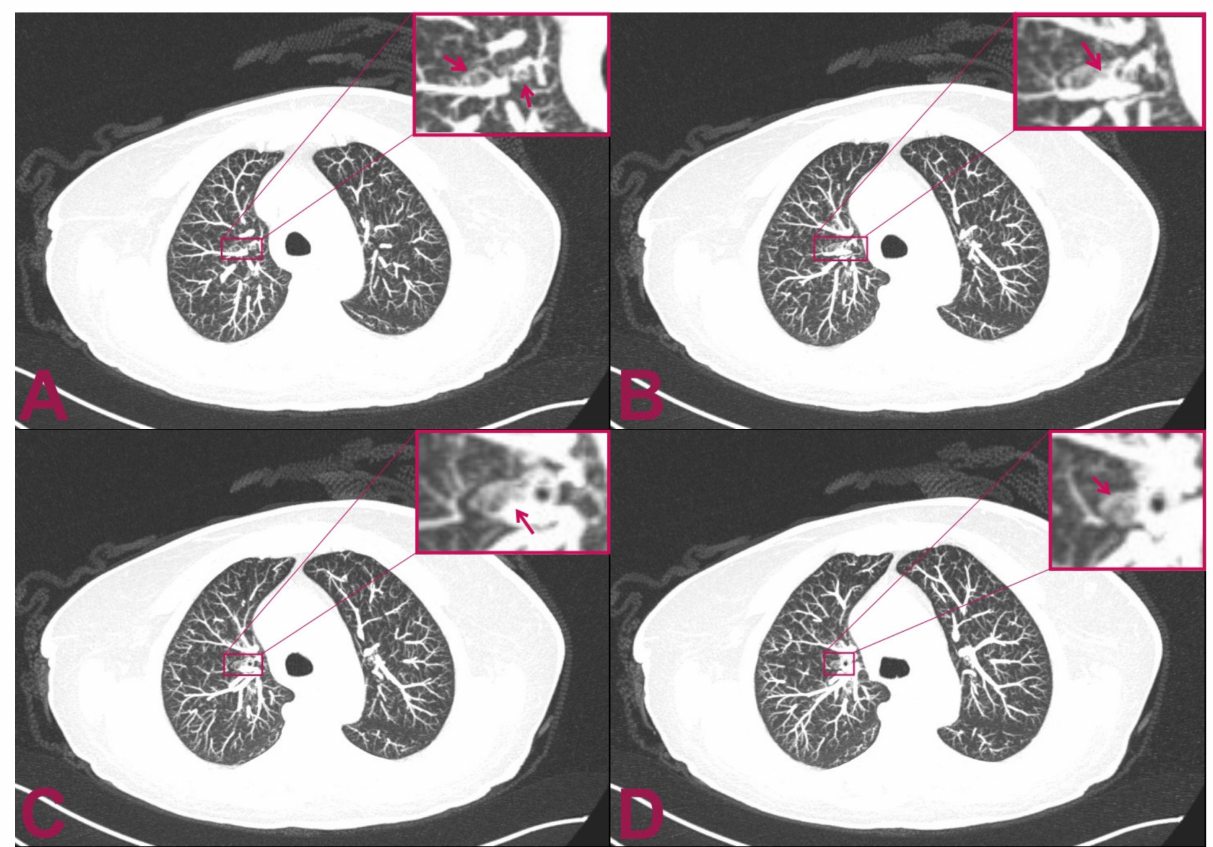
Figure 3. Postoperative multilayer spiral CT scan of the chest with intra-venous administration of contrast medium. The patient is affected by intramedullary cervical metastasis from a primary small-cell neuroendocrine carcinoma of the lung. ( A , B ) Axial views show two small, rounded, and confluent nodules located at the level of the superior segment of the right upper lobe of the lung which have a maximum diameter of 9 × 3 mm. ( C , D ) The CT axial view shows an additional 2.5 mm abnormal small, solid nodular formation that is located caudally to the previously indicated nodules. The mass appears adherent to the bronchial tube and measures 8 mm in maximum